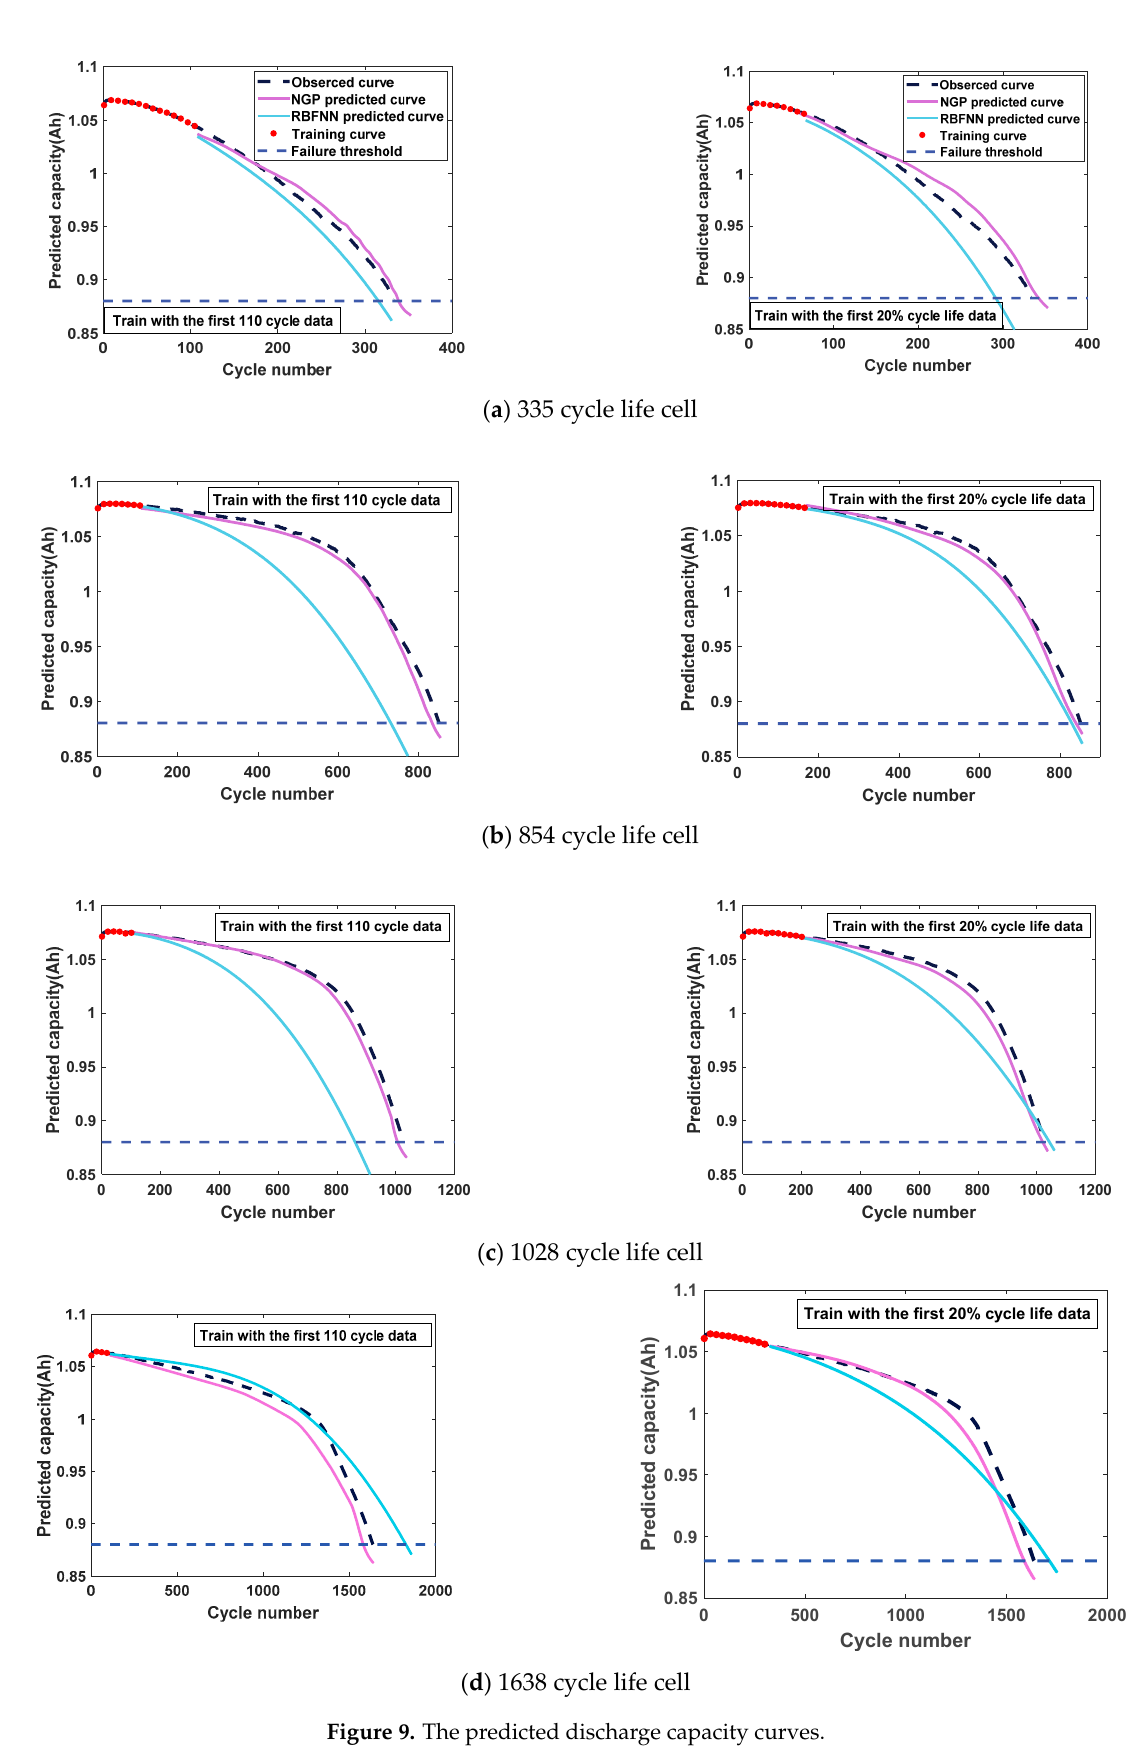
Figure 9. The predicted discharge capacity curves.